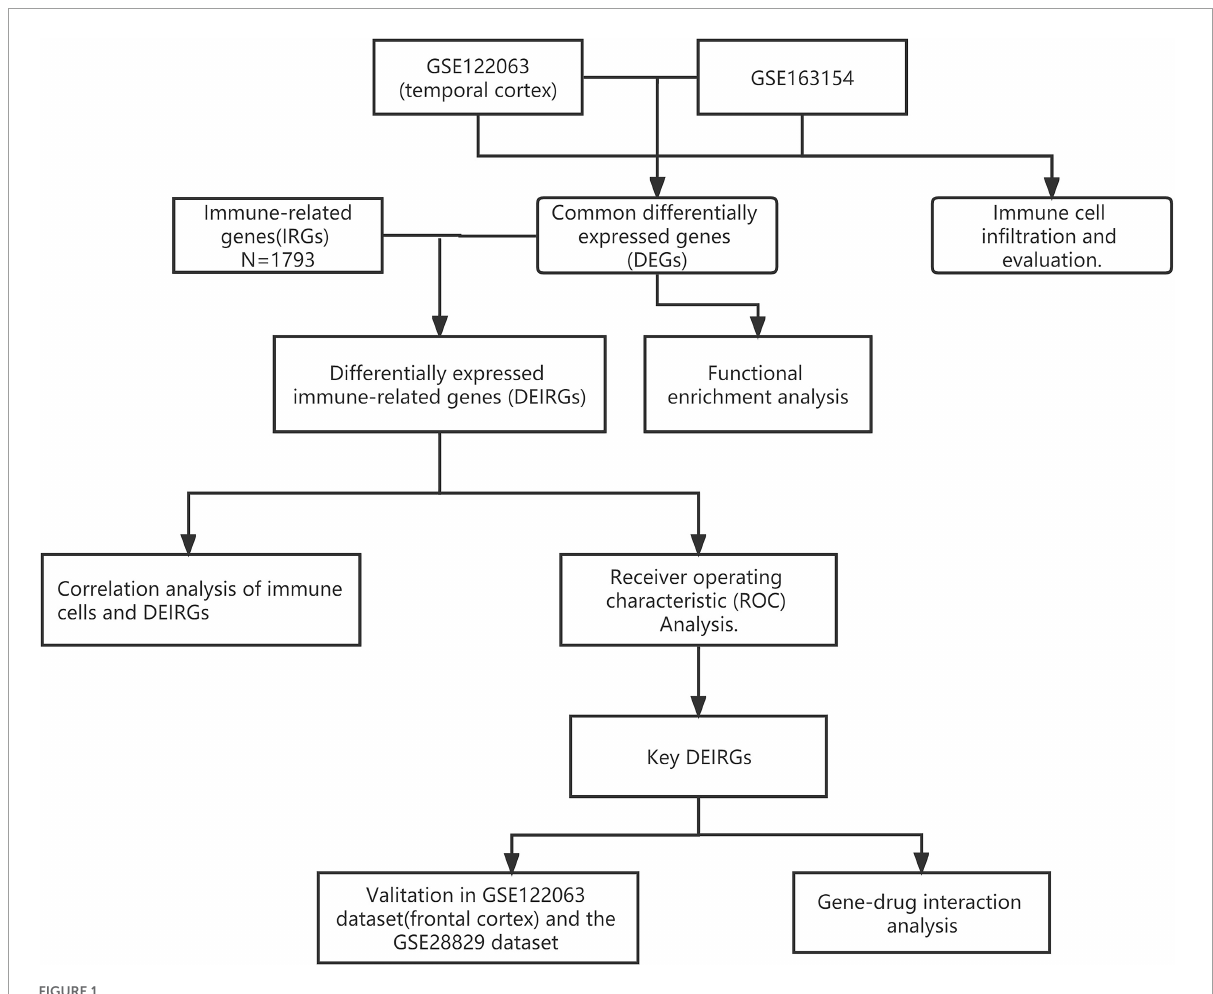
FIGURE1 Flowchart of the analytical steps of this study.